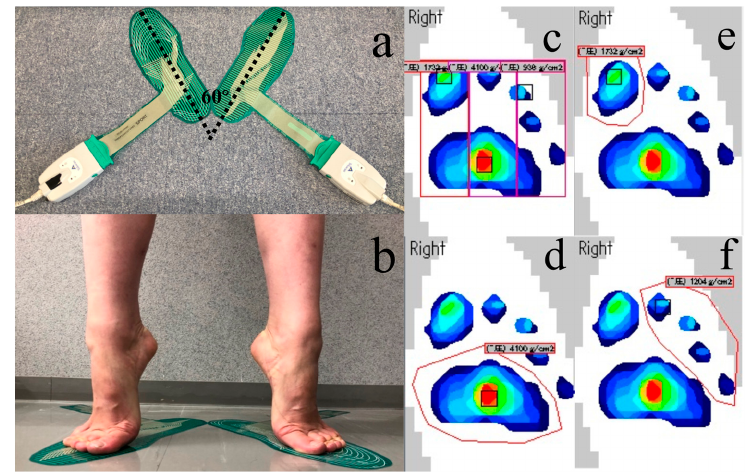
Figure 3. Experimental set-up showing ( a ) the installation of the sensor; ( b ) the limb positions (relevé on demi-pointe); ( c ) medial, middle, lateral from lift; ( d ) metatarsals hand; ( e ) hallux area and ( f ) toe